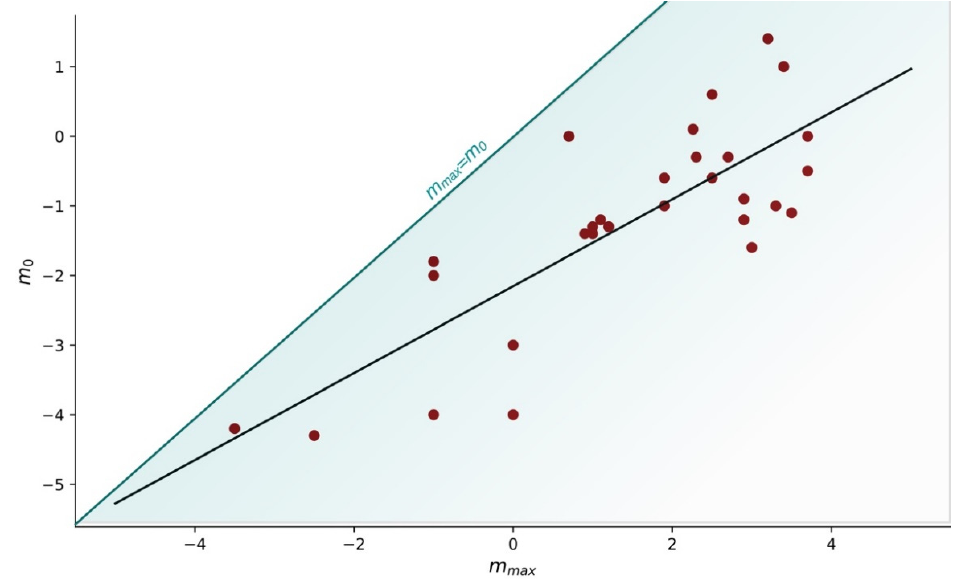
Figure 1. Statistical trend between m max and m 0 and matching linear regression m 0 = 0.62 m max − 2.15 in black.